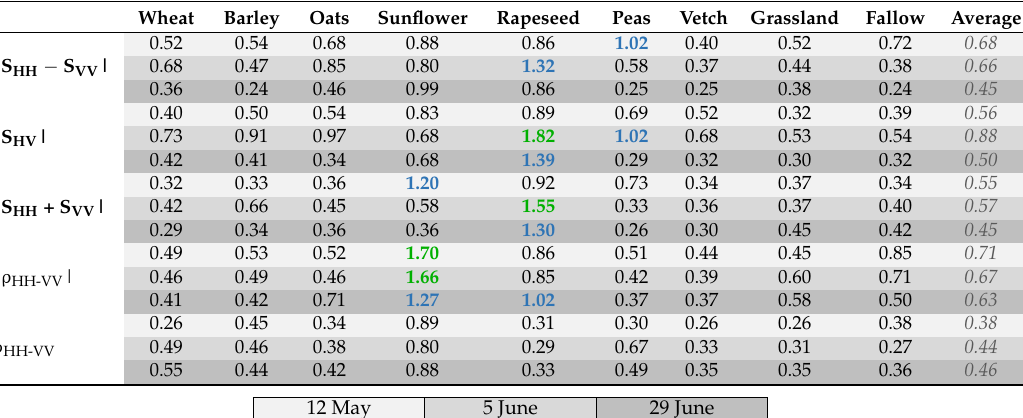
Table 5. Average JM distance for each studied crop and date as well as the average of all crop pairs, for Pauli decomposition features (|S HH ´ S VV |, |S HV |, and |S HH + S VV |), | ρ HH-VV |, and φ HH-VV . Colors and shades as in Table 1. Wheat Barley Oats Sunflower Rapeseed Peas Vetch Grassland